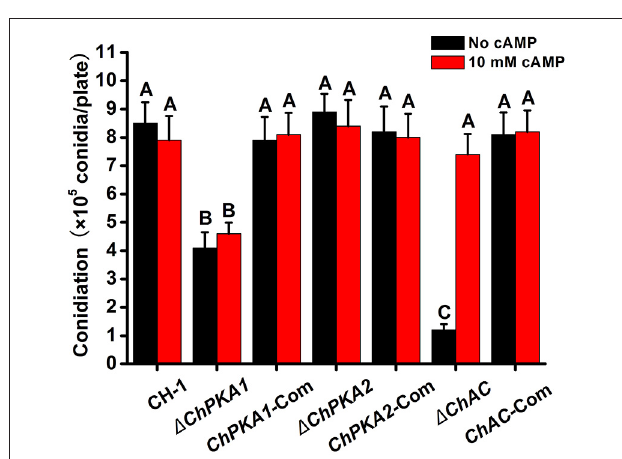
FIGURE 4 | Conidial production of indicated strains. Conidiation of indicated strains cultured on PDA plates with (red) or without (black) exogenous 10mM cAMP at 25 ◦ C for 7 days. Conidiation of each strain was determined by collecting conidia with a hematocytometer. Bars represent standard deviations of three replicates. Different letters in the graph indicate statistical differences, P ≤